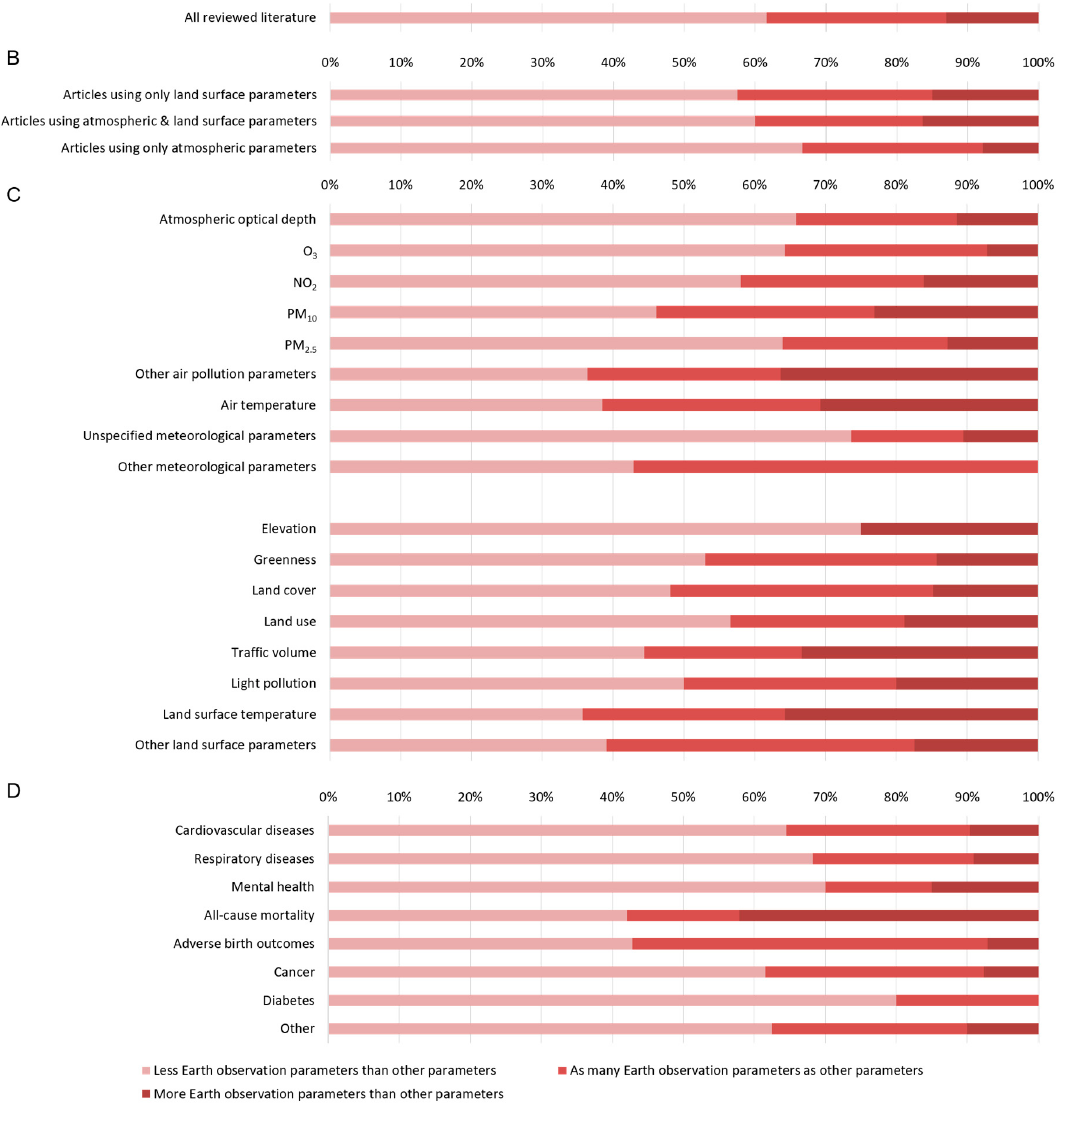
Figure 11. Earth Observation contribution to all reviewed articles ( A ), and articles with respective methodological focus ( B ). Earth Observation contribution to articles focusing on specific EO parameters ( C ), and specific NCDs ( D ).